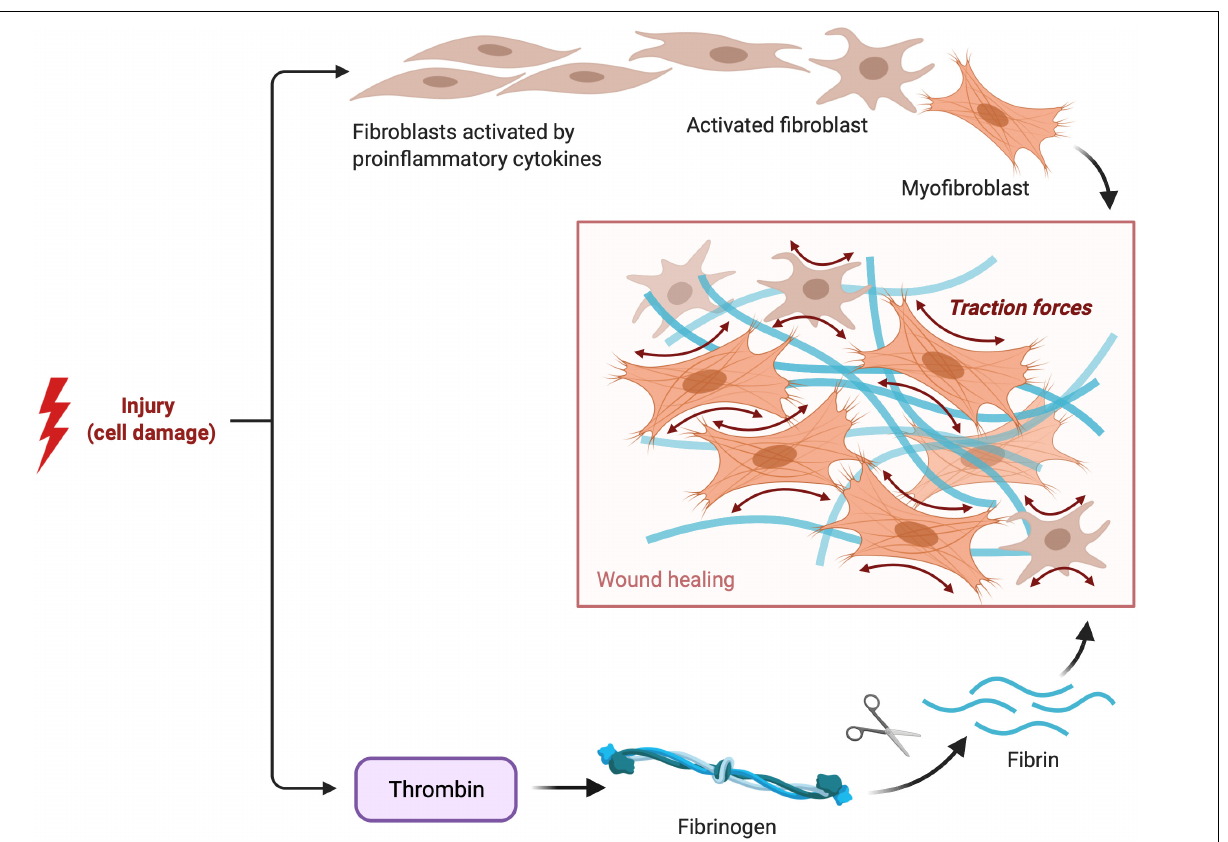
FIGURE 2 | Fibroblast and Fibrin Activity in tissue healing. Visual representation of the pathophysiological process of reparative fibrosis after an injury to the